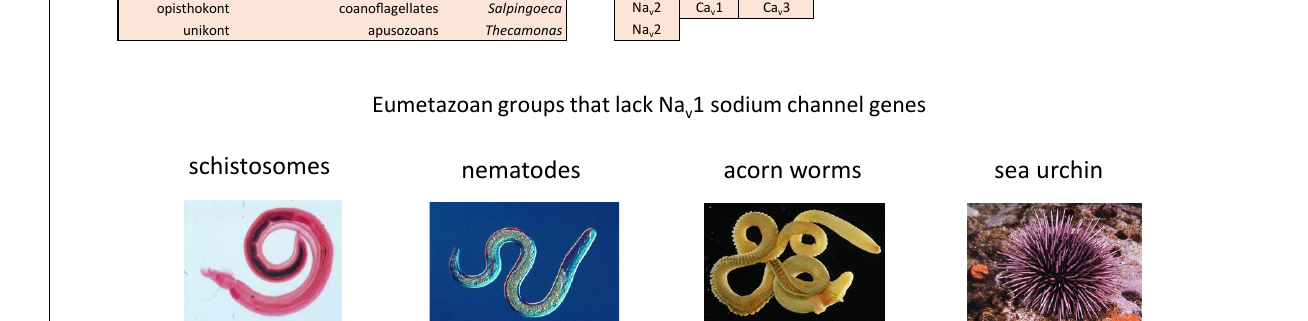
of the HFS site (D and E) residues required for coordination and selective passage of Na + ions through the Na v 1 channel pore (Shen et al., 2017). Homologous positioning of the